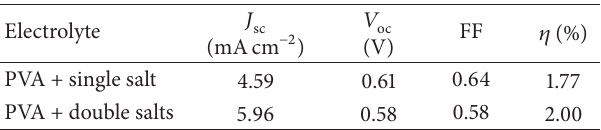
Figure 5: The absorption spectra of chlorophyll with various concentrations of CDCA. Table 3: Photoelectrochemical parameters of DSSCs with PVA electrolytes containing single and double salts.